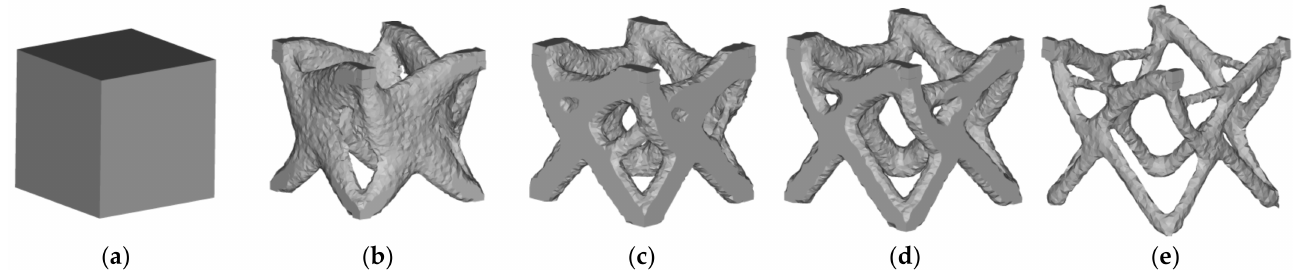
Figure 4. Iterations steps ( a – e ) of the Topology Optimization study for ‘structure 2’: ( a ) design area,